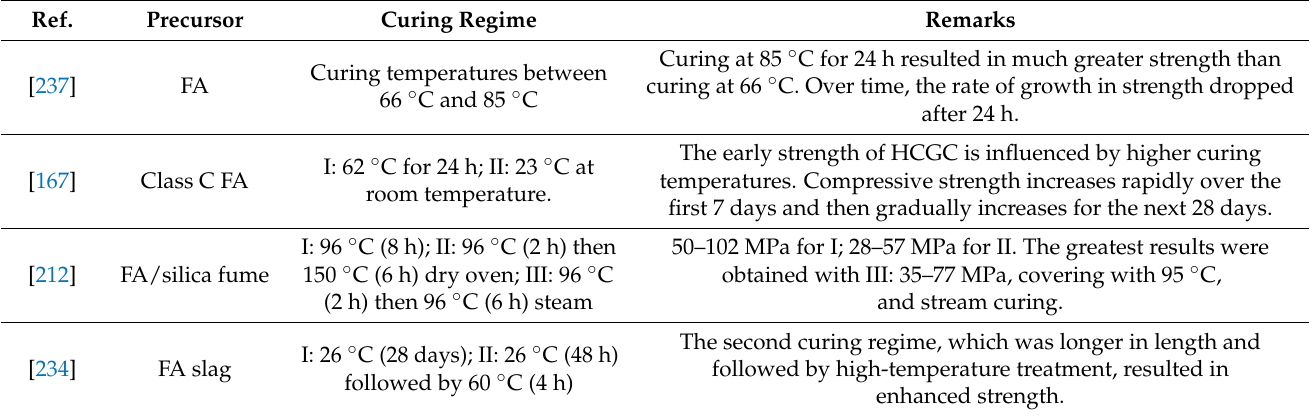
Table 5. Curing regime and its influence on FA-GP concrete CS from different